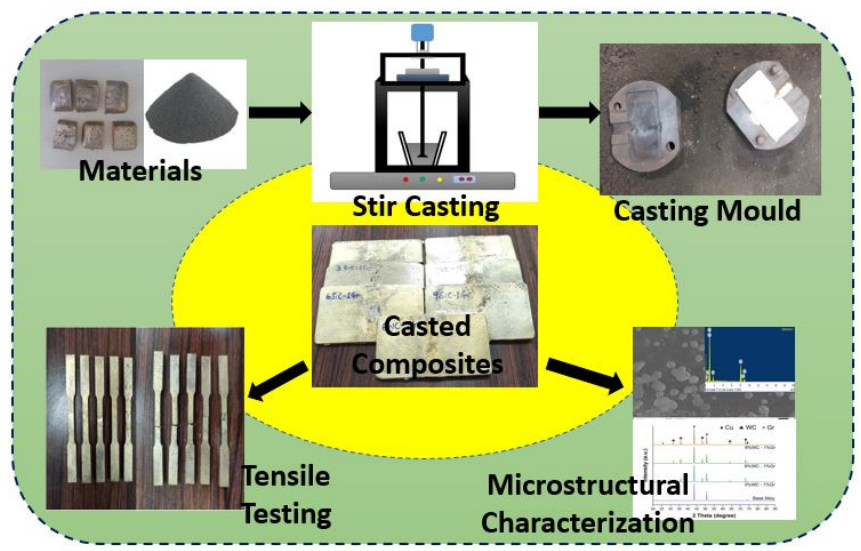
Figure 3. Process flow chat for the current research.